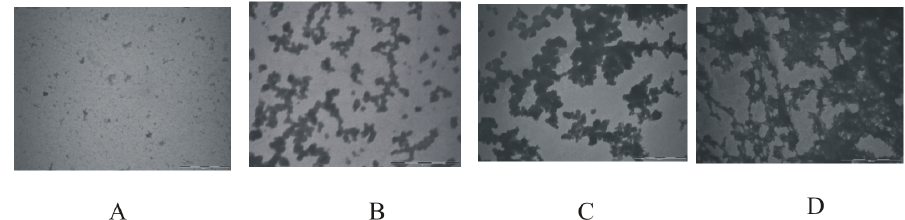
Figure 2. Transmission Electron Microscopic images of lysozyme solution (A) in the native state, and after the incubation at 57 6 C for (B) after 48 h, (C) 61 h and (D) 90 h which correspond to the stages I, II, III and V of Figure 2B, respectively.